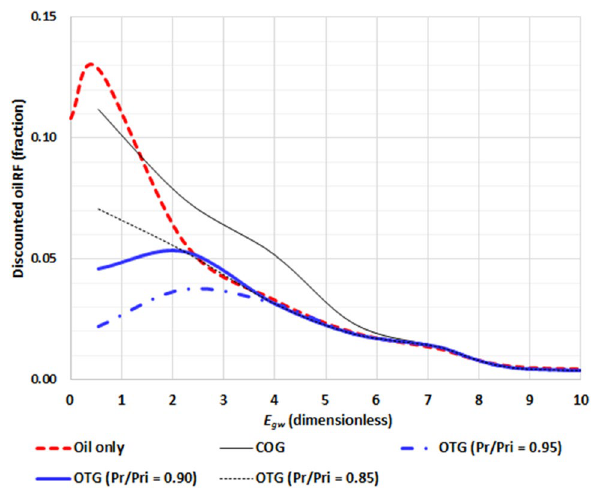
Fig. 4 Discounted oil RF versus E gw (10% discount rate) with vertical oil producers. Note that E gw = 0 refers to the undersaturated cases